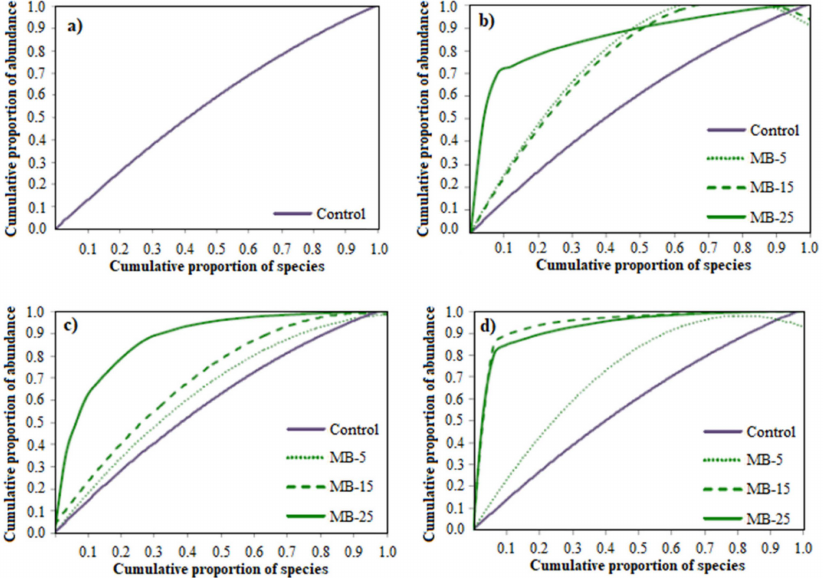
Figure 2. Pareto–Lorenz distribution curves based on PCR-DGGE patterns from intestinal samples) of juvenile S. aurata fed experimental diets for 30 days at day 0, 7, 15, and 30 (( a – d ),